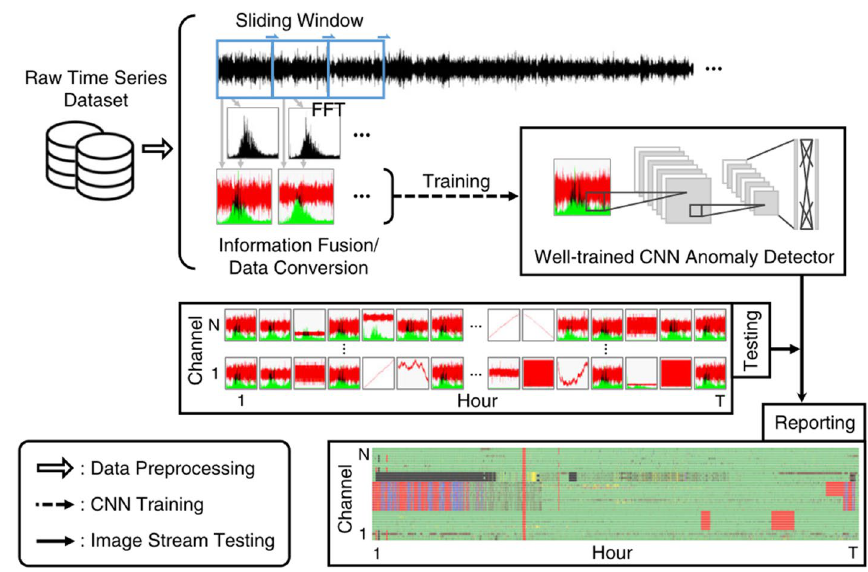
Fig. 1 The anomaly detection method proposed by Tang et al